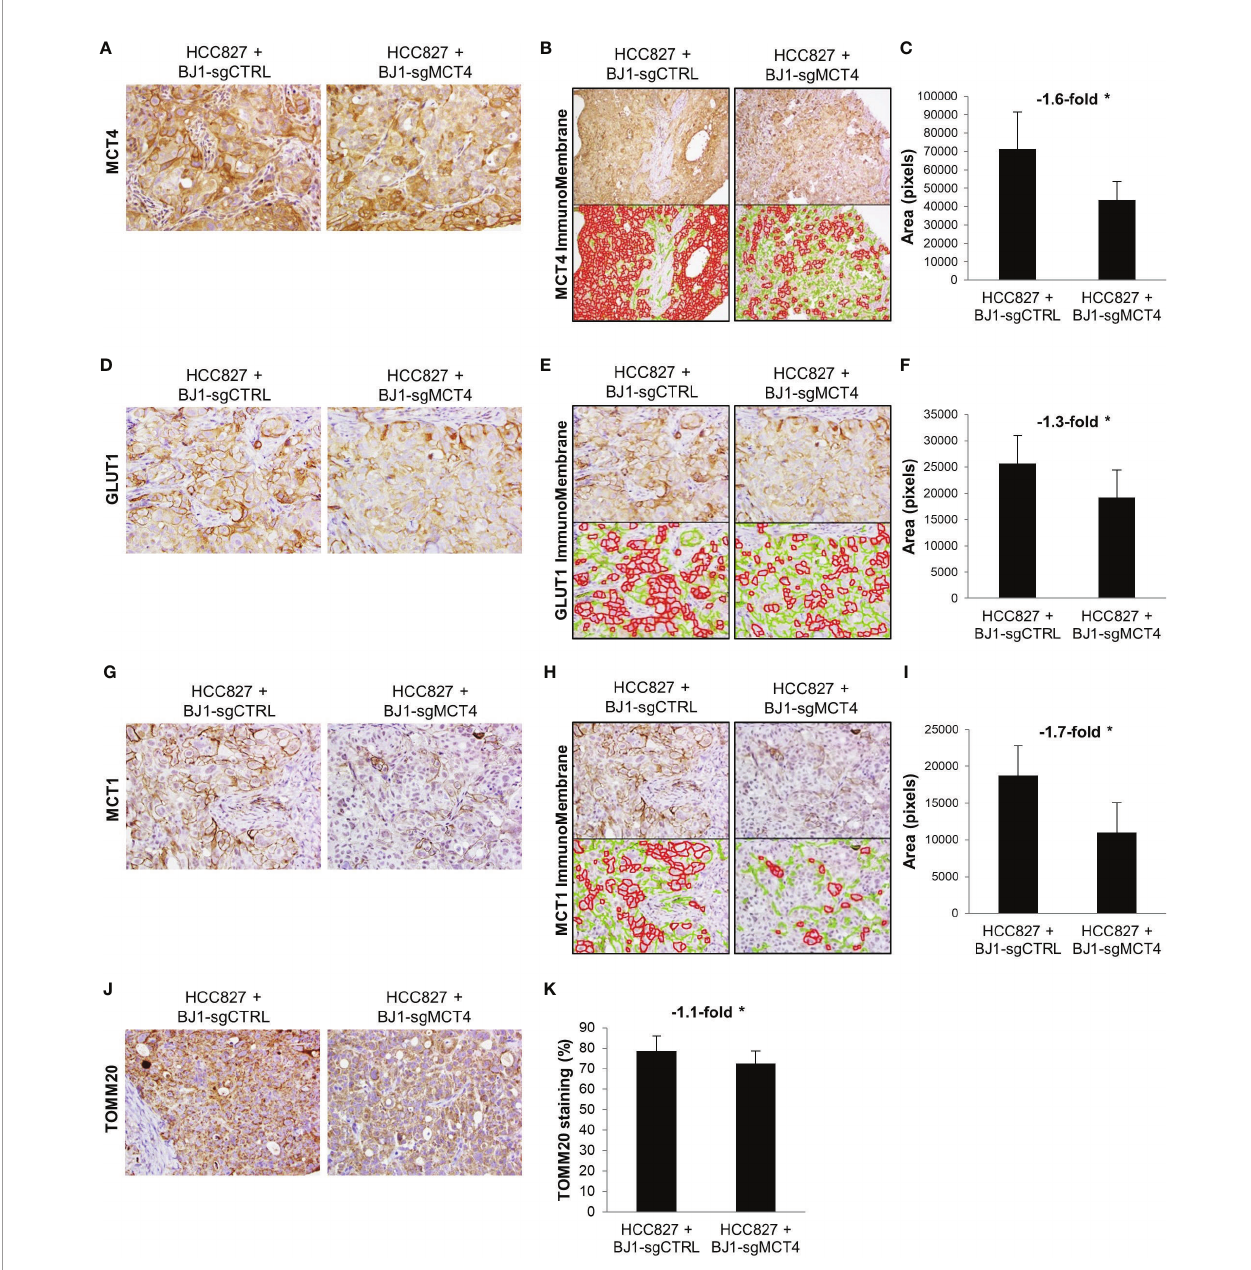
FIGURE 8 | Effects of fi broblast MCT4 on tumor metabolism. The metabolic markers MCT4, GLUT1, MCT1 and TOMM20 were assessed by immunohistochemical staining in tumor xenografts generated from the co-injection of HCC827 with BJ1-sgCTRL or BJ1-sgMCT4. Representative IHC images of MCT4 (A) , GLUT1 (D) , MCT1 (G) and TOMM20 (J) staining. Membranous staining of MCT4 (B, C) , GLUT1 (E, F) and MCT1 (H, I) in HCC827 cells was identi fi ed with the ImmunoMembrane software and quanti fi ed with ImageJ. The ImmunoMembrane software detects and labels strong membranous staining in red and weak staining in green. Only staining labeled in red was quanti fi ed by ImageJ as the area in pixels of the total image covered by the red labeling. Mitochondrial staining of TOMM20 on HCC827 cells was quanti fi ed by Aperio (K) . Representative images for each group are shown. All IHC images were acquired at 40X, except for MCT4 quanti fi cation in panel (B) that is 20X. Student ’ s t-test was used for statistical analyses